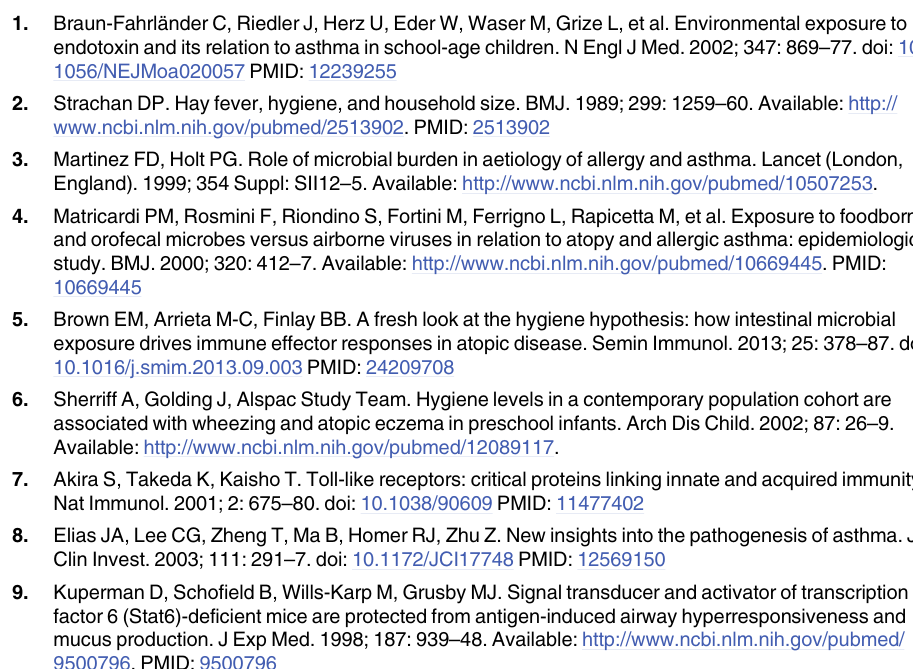
S1 Table. Tabular statistical results obtained by performing the one-way ANOVA with Tukey ’ s Multiple Comparison Test as post test for comparison of individual groups at each MCh concentration. (cid:1) P < 0.05; (cid:1)(cid:1) P < 0.01 and (cid:1)(cid:1)(cid:1) P <